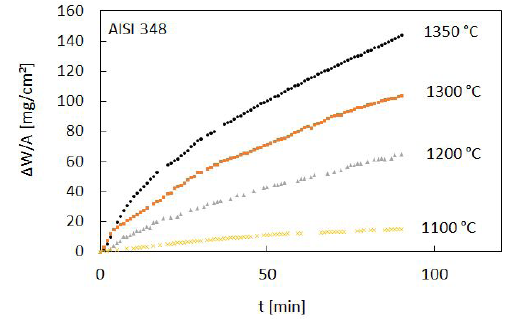
Figure 1. Evolution of the weight gain for AISI 348 at 1100 °C, 1200 °C, 1300 °C and 1350 °C in water.